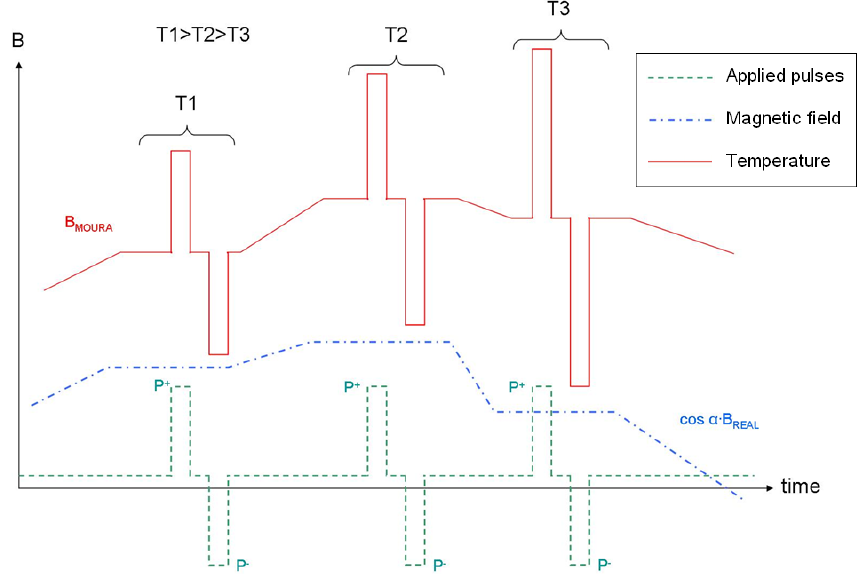
Figure 7. Sketch of applied pulses, real external magnetic field, registered signal by MOURA for different temperatures (T1, T2 and T3) as a function of